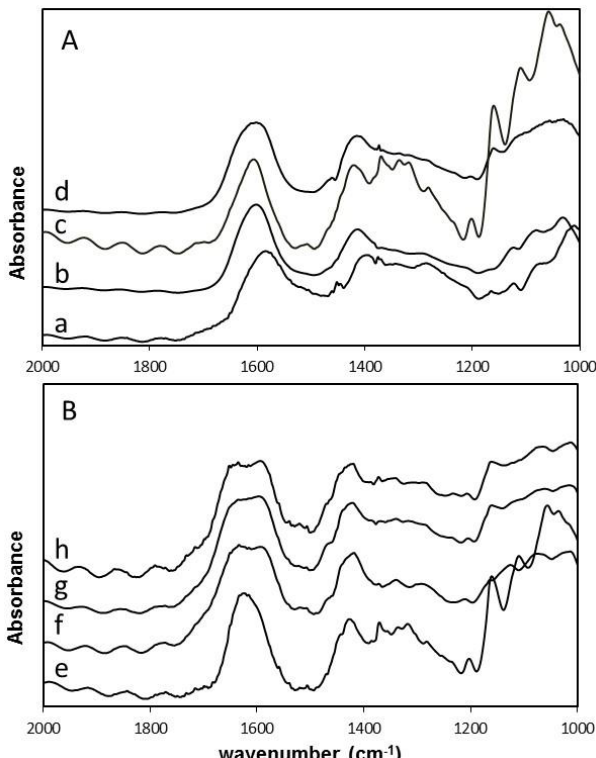
Figure 7. FT-IR spectra of freeze dried gel cylinders of 1.0% M. pyr. alginate and 0.75% CNF. ( A ) Calcium unsaturated samples and starting materials; ( B ) calcium saturated samples. M. pyr. powder, no calcium. ( a ); M. pyr , Ca-unsaturated ( b ); ox. CNF powder, no calcium ( c ); M. pyr. + ox CNF, Ca-unsaturated ( d ); Ox. CNF, Ca-saturated ( e ); M. pyr. , Ca-saturated ( f ); M. Pyr. + ox. CNF, Ca-saturated ( g ); and M. Pyr. + mechanically-fibrillated CNF, Ca-saturated ( h ).